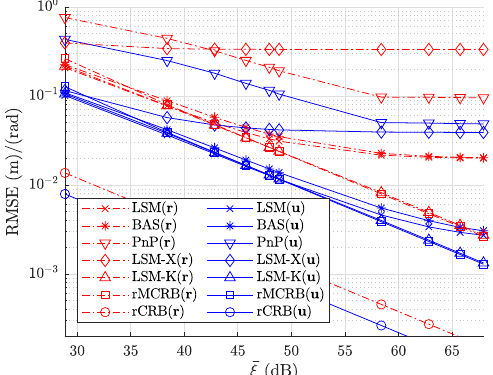
Figure 7. RMSE for position and orientation estimates, compared with the mean received SNR ¯ ξ